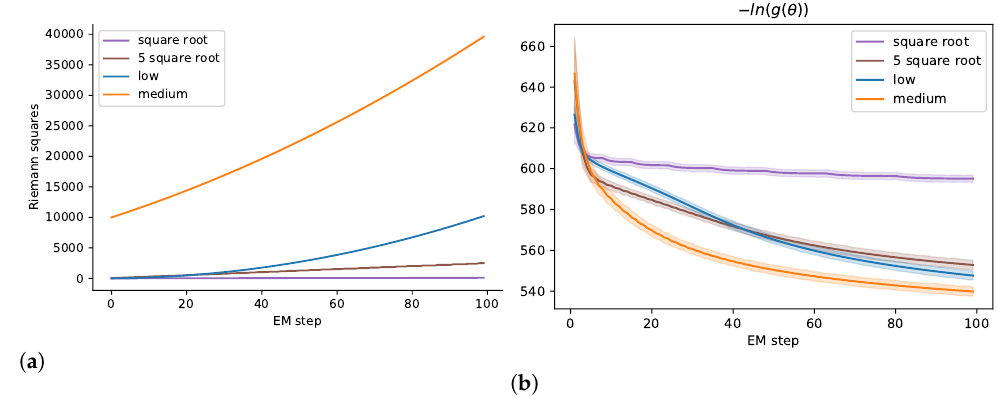
Figure 3. ( a ) Visual representation of the number of Riemann intervals over the EM steps for each profile ϕ i . In higher dimension, the computational complexity of the profiles are very different. More precisely, the total number of Riemann squares computed over 100 EM iterations are: 4534 for “square root”, 125,662 for “5 square root”, 348,550 for “low” and 2,318,350 for “medium”. ( b ) For each profile, average evolution of the negative log-likelihood, with standard deviation, over 50 simulations. The “square root” profile performs poorly. However, the other three are comparable despite their different computational